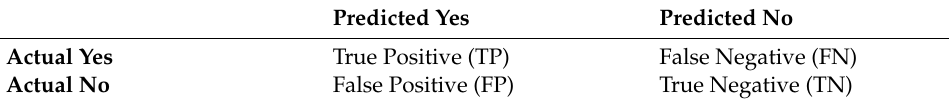
Figure 6. MFs for classifier 2. Table 5. Description of the confusion matrix.